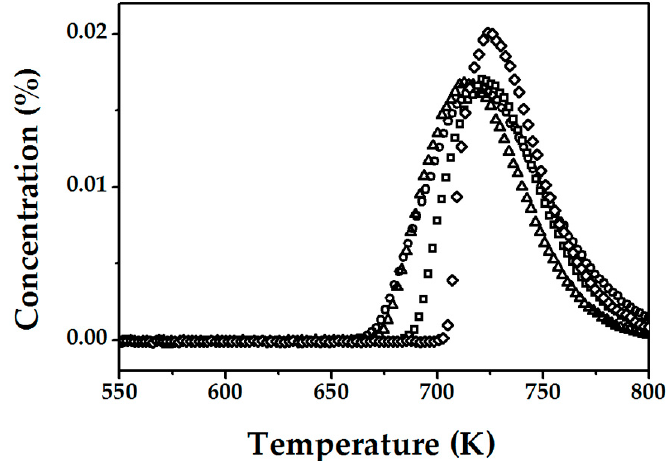
Figure 4. NO-TPD profiles for FeZSM-5 1200Fe activated in He at 1273 K for 1 ( ), 3 ( ), 5 ( ), and 15 h ( ) after contact with N 2 O at 523 K for 20 min.